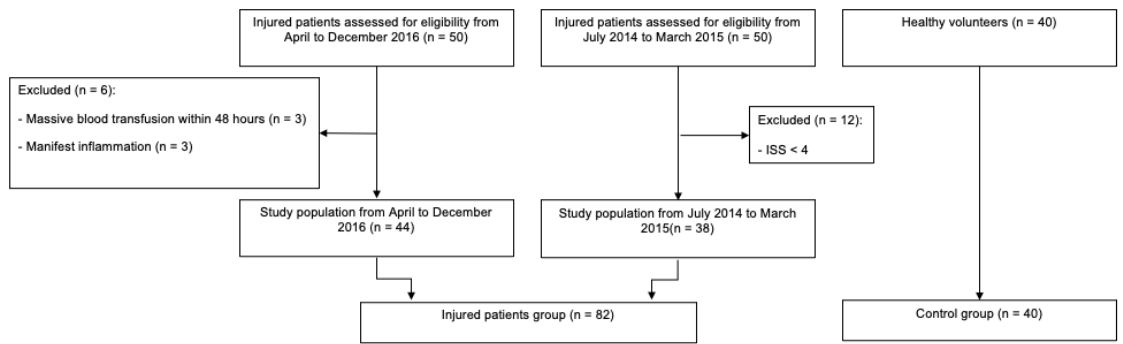
Figure 1. Flowchart of the patients and the volunteers included in this study.